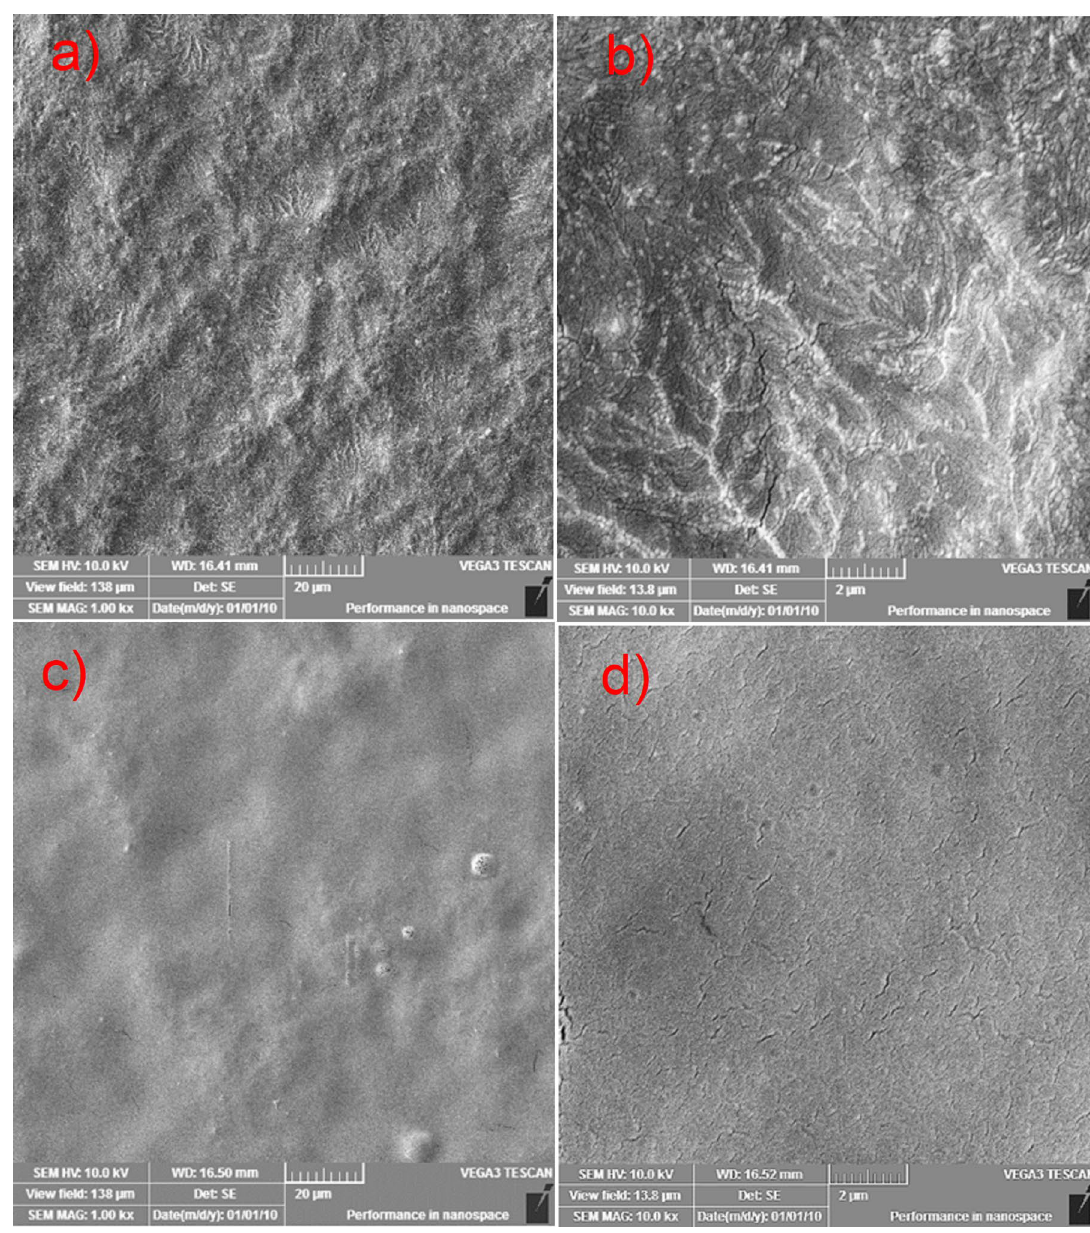
(a, b) and NC (c, d) films cast on glass sheet at two magnifications 1,000X (a, c) and 10,000X (b, AA ex